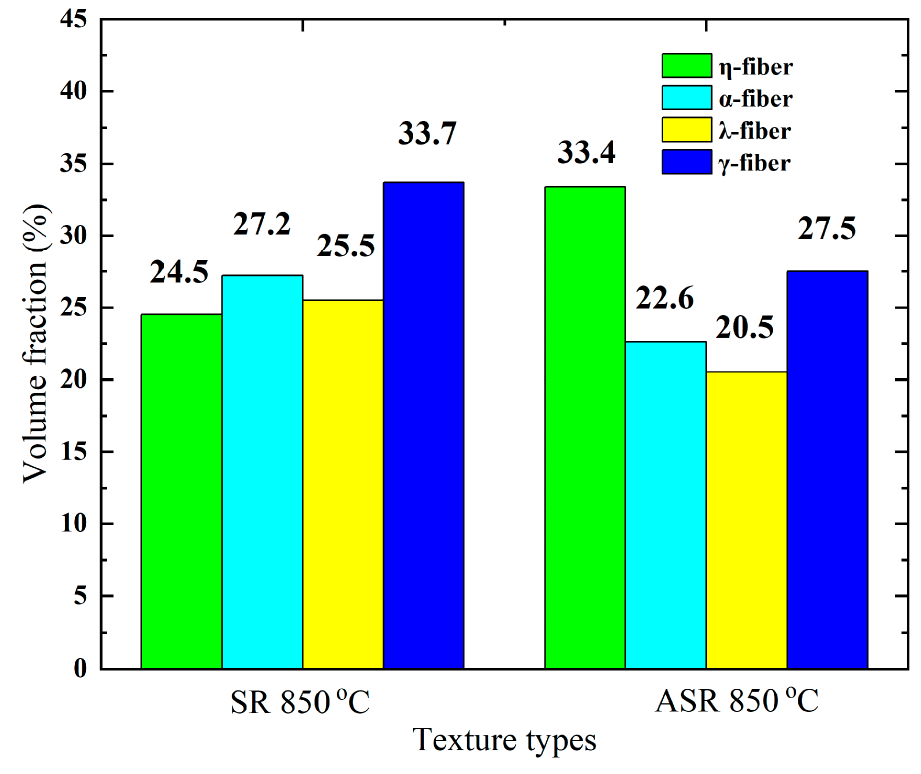
Figure 10. Comparison of four typical texture components after annealing at 850 ◦ C for SR and ASR